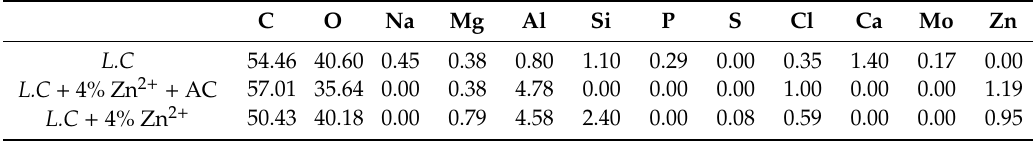
Table 1. Percentages by mass of the chemical elements present on the fiber surface of the raw Lu ff a cylindrica ( L.C ) and the hybrid materials L.C + 4% Zn 2 + and L.C + 4% Zn 2 + + AC. C O